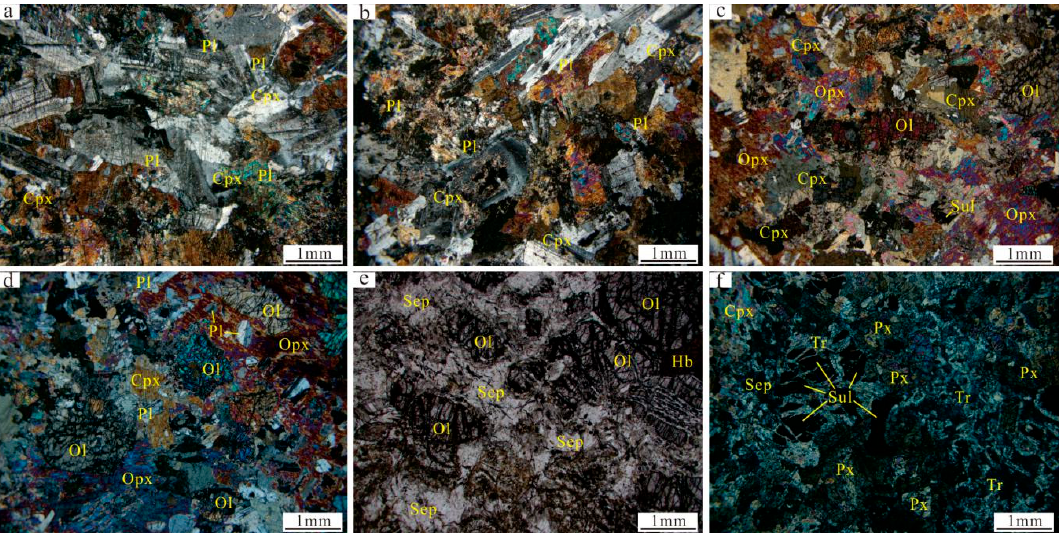
Figure 6. Representative microphotographs of mafic-ultramafic rocks in the Niubiziliang Ni-(Cu) deposit. ( a ) Gabbro; ( b ) Melagabbro; ( c ) Websterite with sulfides; ( d ) Olivine pyroxenite; ( e ) Harzburgite with serpentinization; ( f ) Harzburgite with sulfides and serpentinization, talcitization. Pl, plagioclase; Cpx, clinopyroxene; Ol, olivine; Opx, orthopyroxene; Sep, serpentine; Hb, hornblende; Sul, sulfide; Tr, tremolite; Px, pyroxene.